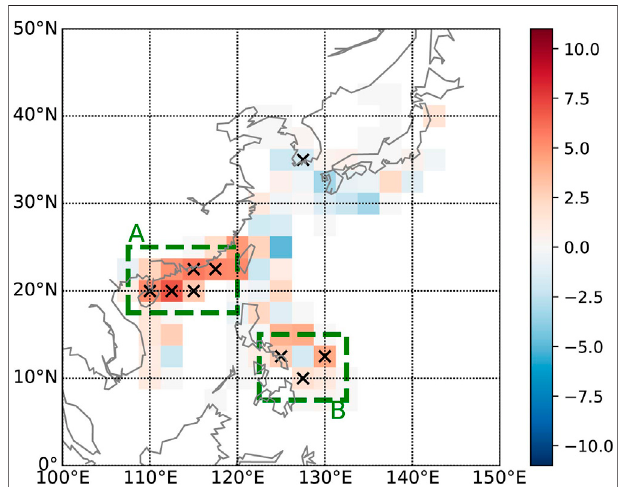
FIGURE 3 | Changes in Δ V 24 (unit: kt) before landfall during JJASON from 1970 – 1994 to 1995 – 2019. Black crosses refer to differences signi fi cant at the0.05 level based ona Student ’ s t -test. Greenboxes highlightRegionsA and B.